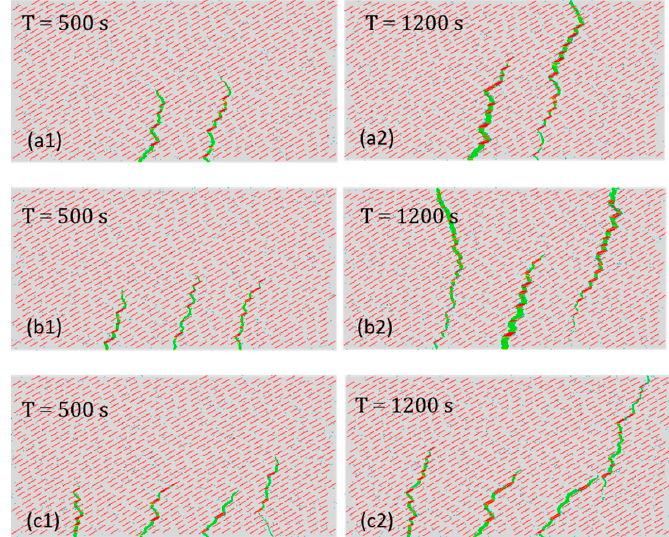
Figure 16. Effect of cluster numbers on hydraulic fracture propagation. ( a1 , a2 ) Two clusters fracturing scenario at fracturing time T = 500, 1200 s; ( b1 , b2 ) three clusters fracturing scenario at fracturing time